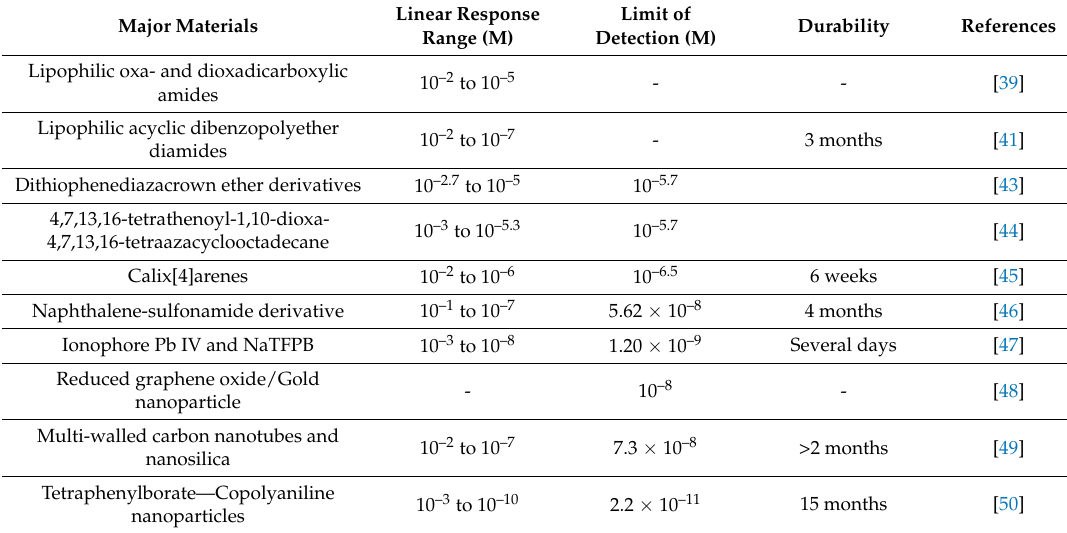
Table 1. Various types of lead-selective polymeric